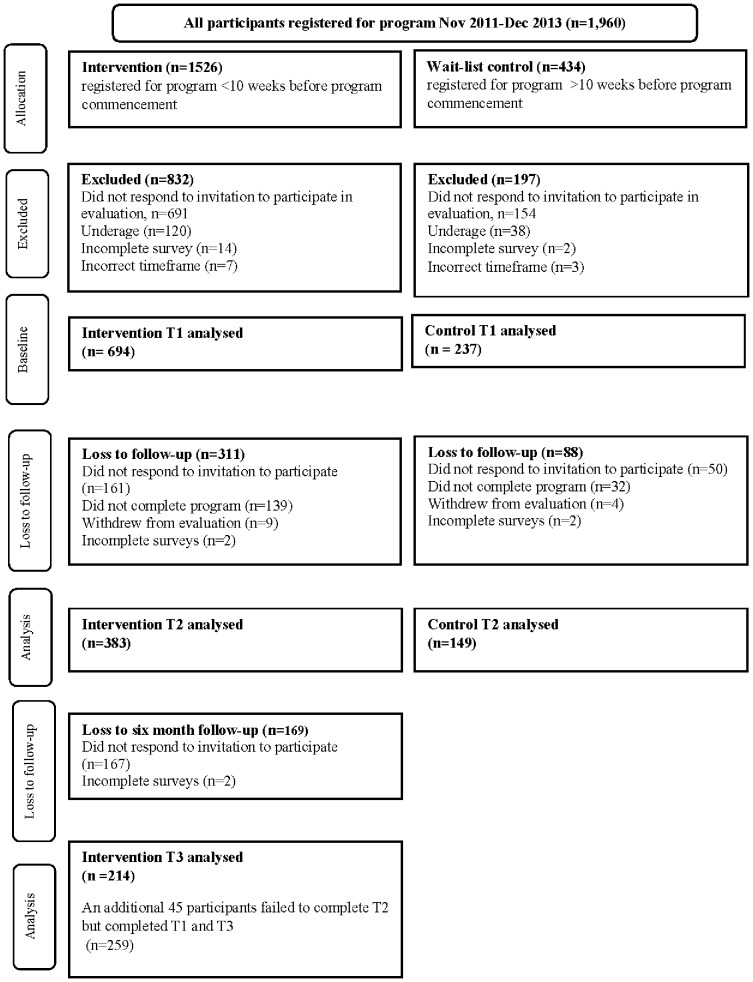
Evaluation participation over time.